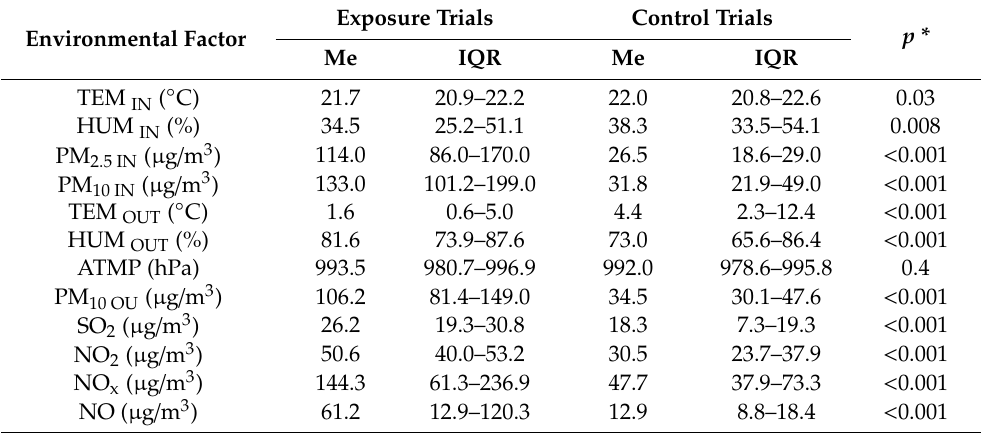
Table 2. Distribution of environmental conditions recorded during exercise trials ( n =